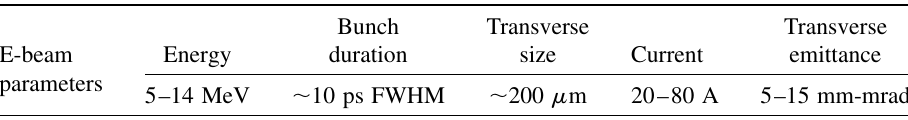
TABLE I. Electron beam parameters for FEL